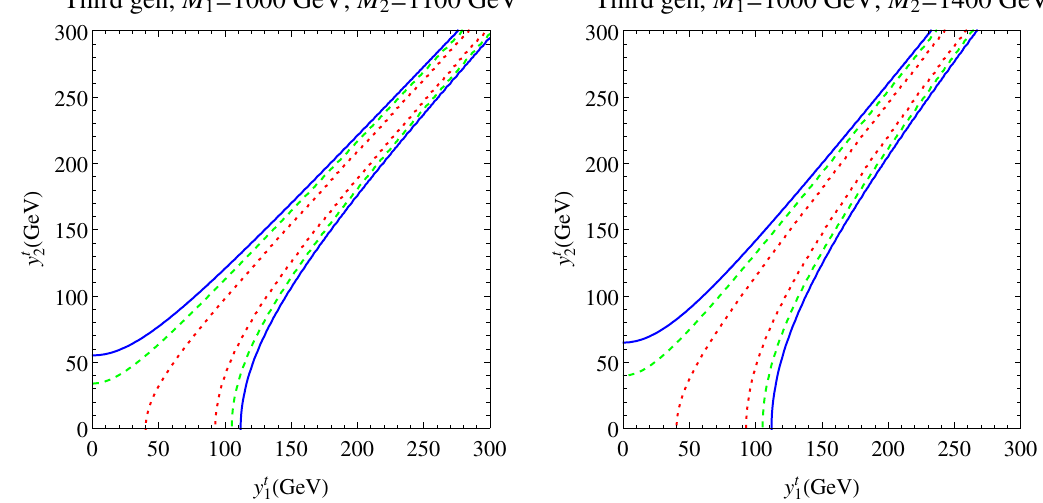
Figure 2 . EWPT bounds (blue line is the 3 (cid:27) bound, green dashed 2 (cid:27) , red dotted 1 (cid:27) , the strip between the lines is allowed) in the case of mixing of the two VLQ multiplets with the third SM quark generation.